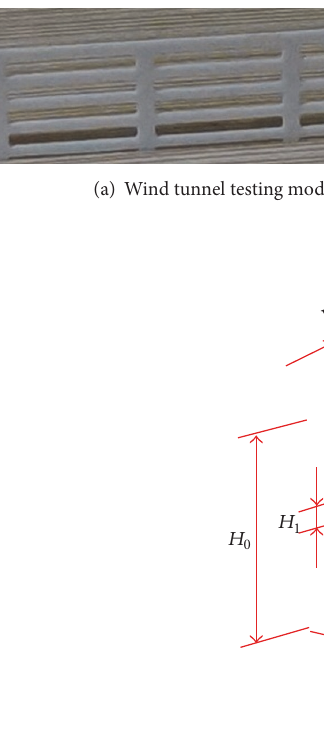
Figure 13: A close-up view of pedestrian guardrail structures ( Case #0